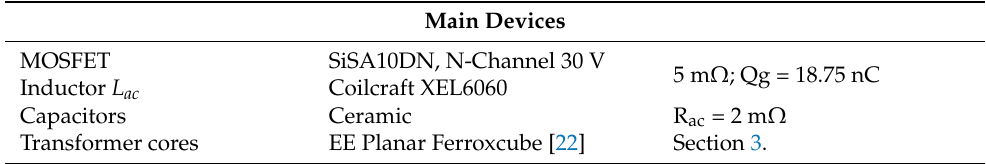
Table 1. Devices or family used for loss